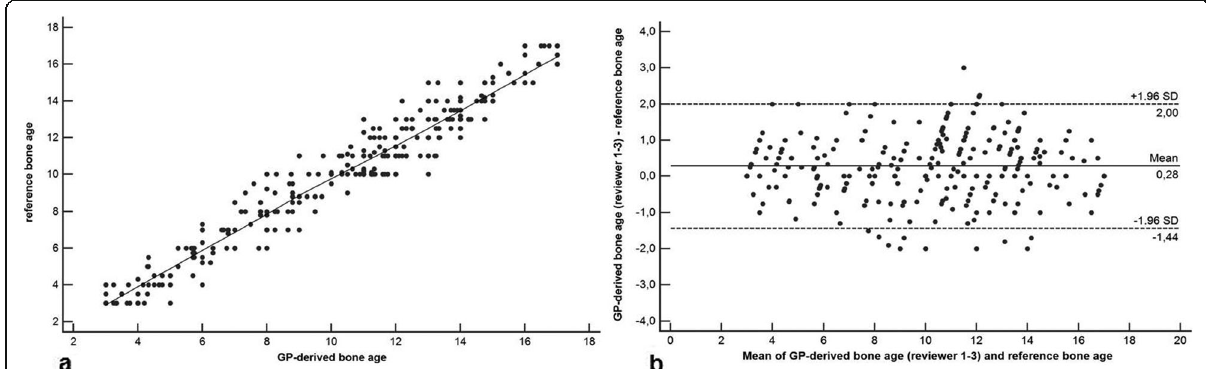
Fig. 4 Correlation and agreement analysis of bone age values assessed by the three radiologists applying the Greulich-Pyle method and the reference values. a Pearson product-moment correlation shows significantly lower correlation with r = 0.901, 95% confidence interval (CI) 0.872 – 0.934, and r 2 = 0.812, 95% CI 0.762 – 0.854, compared to the correlation between values based on the software and the reference values ( p < 0.001). b Bland-Altman plot also demonstrates lower agreement between values assessed by the three radiologists applying the Greulich-Pyle method and the reference values compared to the agreement between values based on the software and the reference values ( p < 0.001). Values are given in years. GP Greulich-Pyle